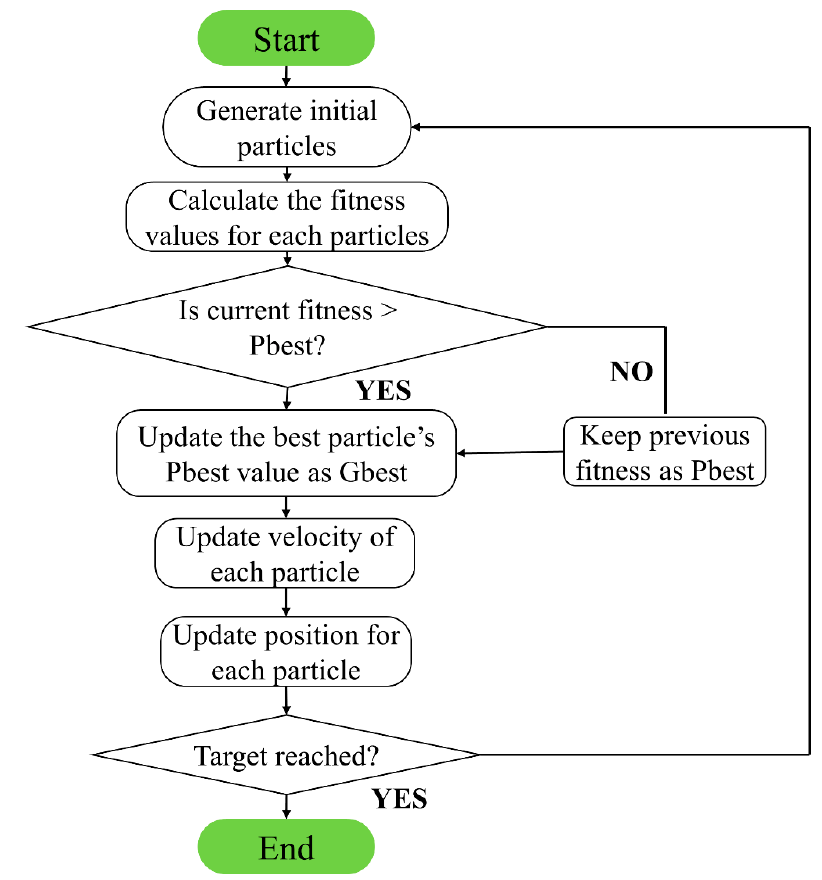
Figure A2. Flowchart of PSO algorithm.